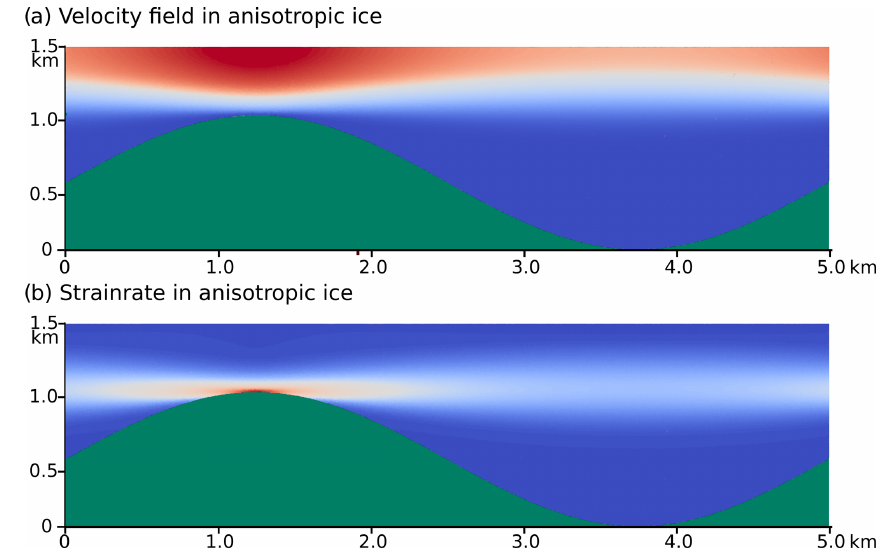
Figure 11. Velocity field and strain rate field in anisotropic ice. The velocity field is vertically subdivided into a fast-flowing upper and an almost stagnant lower part. The strain rate is thus at its maximum in the horizontal shear zone that spans from crest to crest of the bedrock undulations. Green: bedrock, velocity: red: 6.6ma − 1 , blue: 0ma − 1 , strain rate: red: 0.031a − 1 , blue: 0a − 1